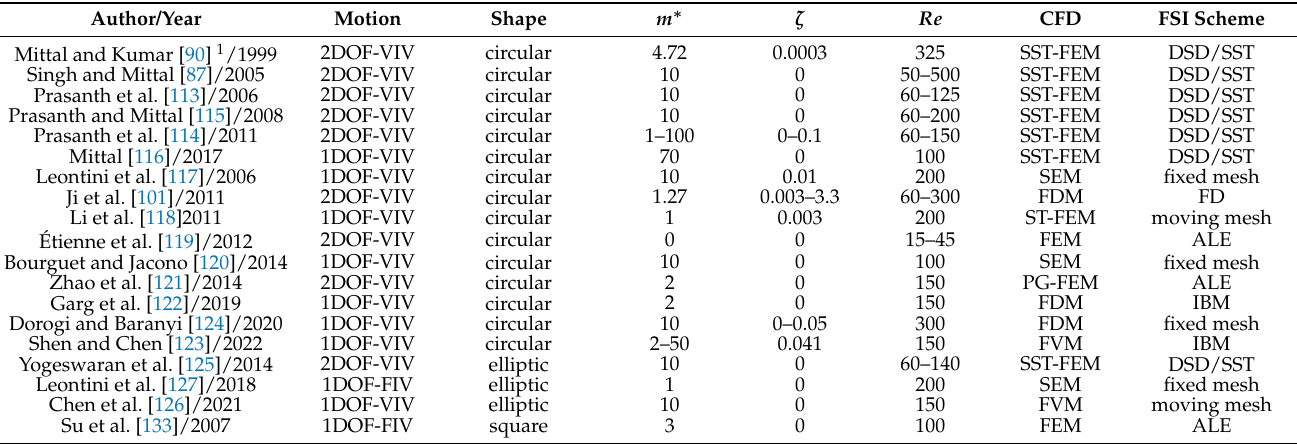
Table 1. Summary of representative 2D DNS studies of flow-induced vibration of a bluff body for low-Reynolds number flows in the laminar flow